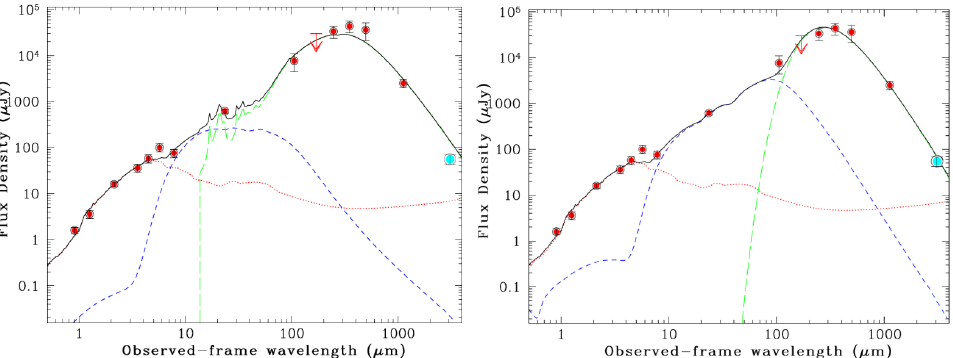
Figure 3. SED fitting of the FRII host galaxy. Photometric points are marked by the filled red circles, while the total fitting model is the solid black line. In both panels the ALMA point is not included during the fitting and is marked by the filled cyan circle. ( Left panel ): The model includes three components: stellar emission (indicated by the red dotted line), the reprocessed emission of the dusty torus surrounding the AGN (blue dashed line), and emission by the cold dust of the host galaxy, heated by starburst activity (green dashed line). ( Right panel ): same as the left panel, where only the cold dust template has been substituted by a simple gray-body model with β =